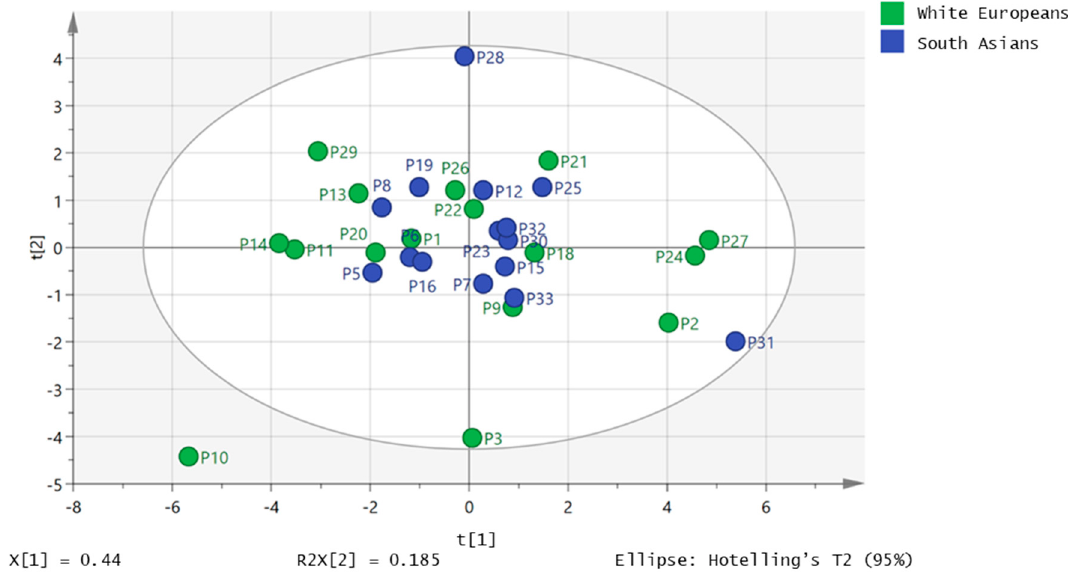
Figure 1. Principle components analysis (PCA) plot for South Asian ( n = 16) and white European ( n = 16) samples based on peak quantities of 19 fatty acids in plasma.